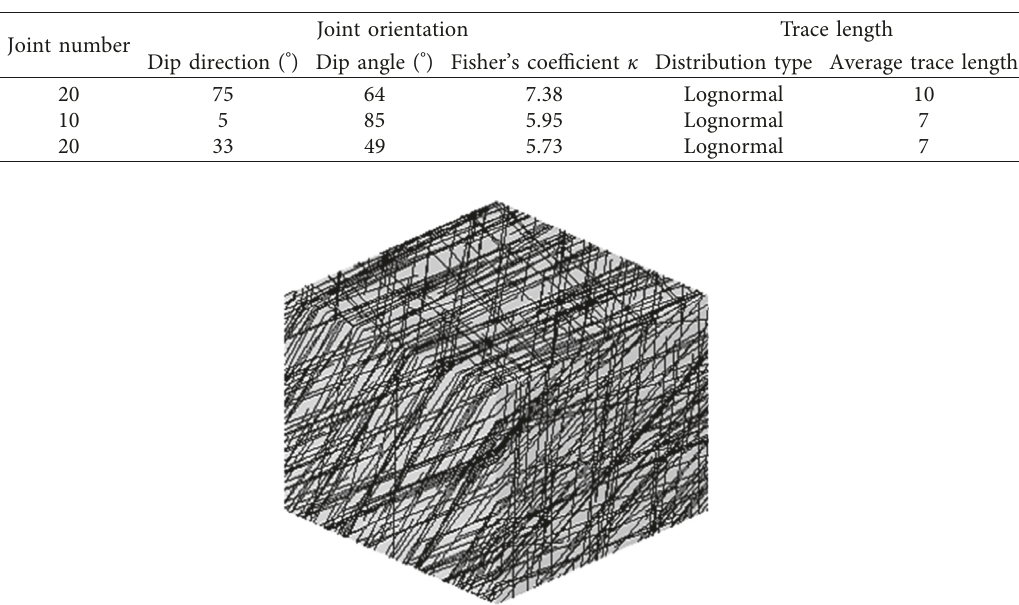
Figure 11: Three-dimensional joint network model of the dam rock mass.